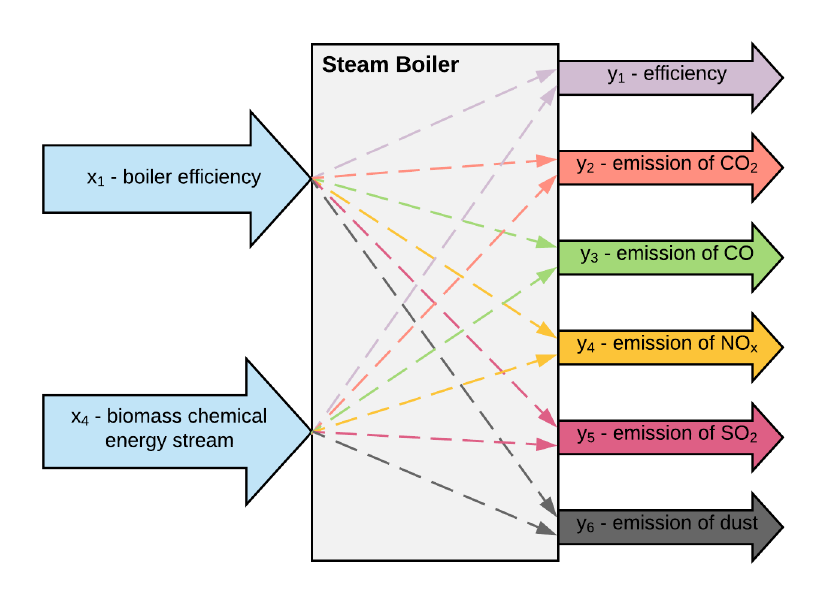
Figure 1. Characteristics of the test